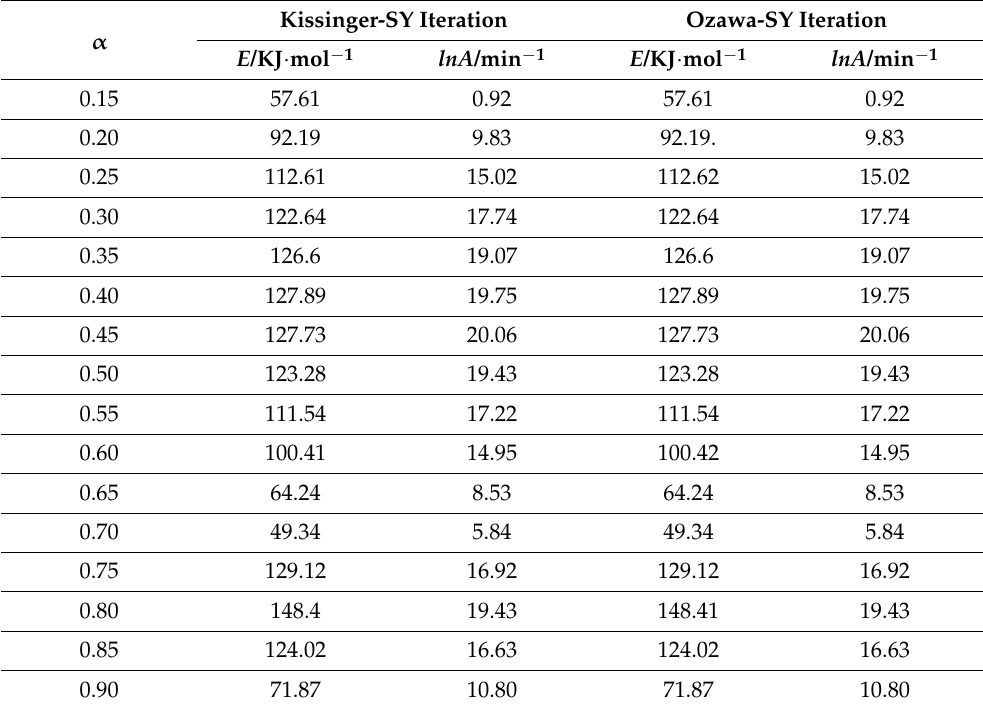
Table 6. Activation energy and preintential factors of Al-lignin at different conversions under Kissinger-SY iteration and Ozawa-SY iteration method.